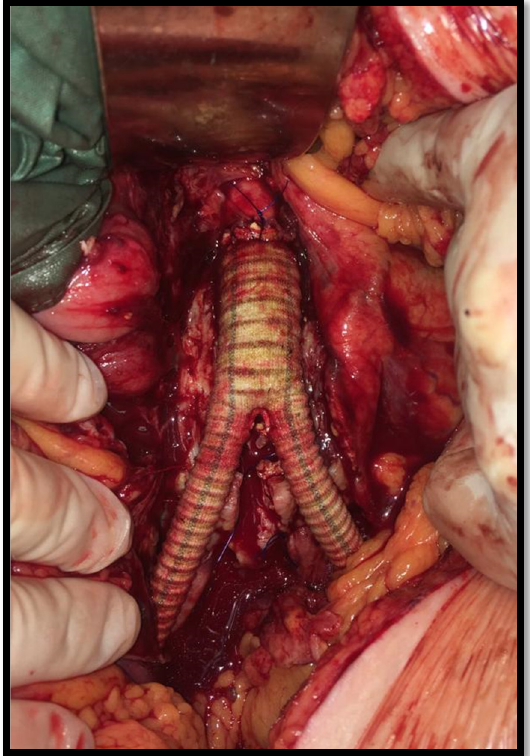
Figure 2. Silver-impregnated graft implanted after mycotic AAA resection. The reasons for using silver grafts are described in Figure 3.